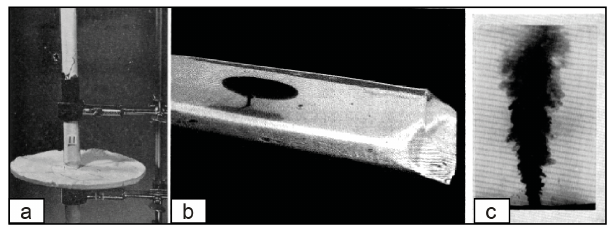
Figure 3. Photographs of early analogue experiments that have in- spired and informed decades of laboratory studies of volcanic and magmatic processes: (a) excavated plaster of Paris mixture that was injected into a layered tank of gelatine to model dyke and sill em- placement (Hubbert and Willis, 1957), (b) water injected into a free- standing triangular prism of gelatine to simulate magma intrusion in a volcanic rift (Fiske and Jackson, 1972), and (c) injection of low- density fluid into a uniform ambient fluid (Morton et al.,